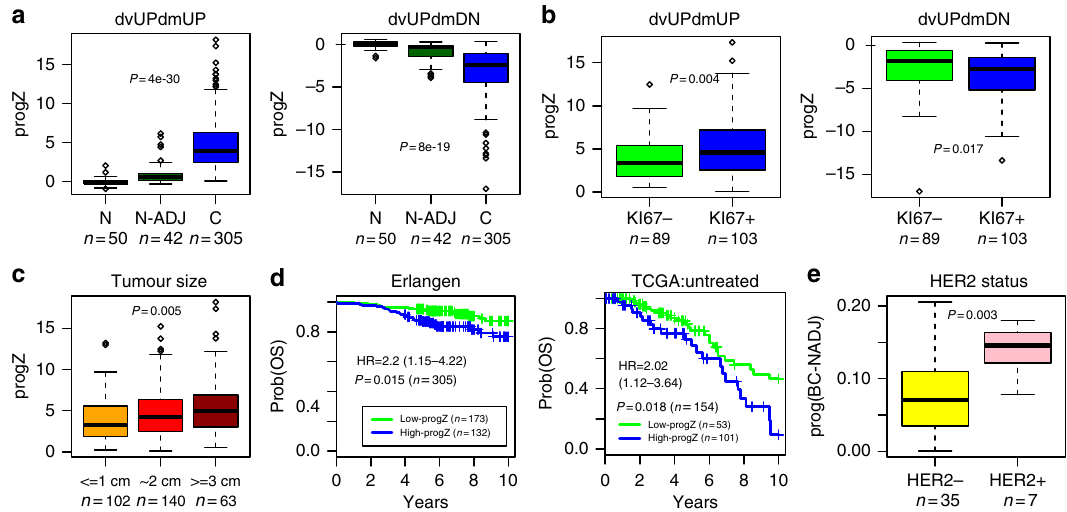
Figure 6 | Progression of field defects correlate with proliferation and overall survival. ( a ) Box plots of progression Z -scores against sample status (N ¼ normal-healthy, NADJ ¼ normal adjacent, C ¼ breast cancer) for each class of DVMC. P -values are from a linear regression. ( b ) Box plots of the same progression Z-scores against the proliferation index (KI67) for each class of DVMC. P -values are from a Wilcoxon-rank sum test. ( c ) Box plot of the progression Z -score of the DVMCs hypervariable and hypermethylated in normal-adjacent compared with normal-healthy, against tumour size. P -value is from a linear regression. ( d ) Kaplan–Meier survival curves for breast tumours stratified into groups of low and high progression Z -scores. Hazard ratio, 95% confidence interval and Cox-regression w 2 test P -value are given. Groups were obtained by clustering the progression Z -scores of all samples into two groups using the pam-algorithm from the cluster R package. ( e ) Box plot of the individualized progression deviation score for each of the 42 breast cancer patients with a matched normal-adjacent sample, against HER2 status. P -value is from a Wilcoxon rank sum